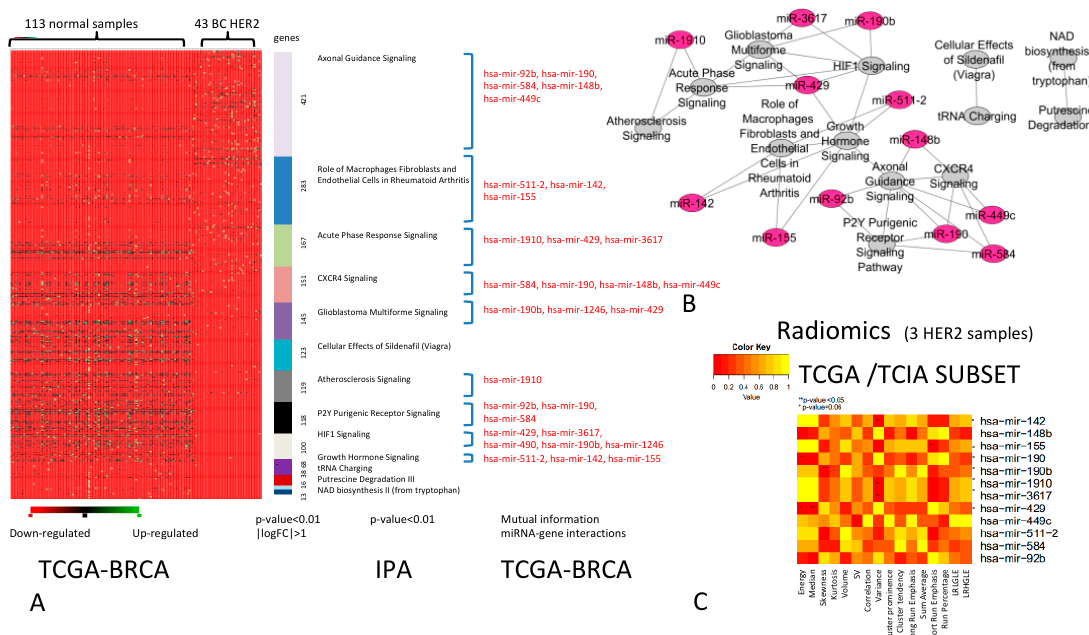
Figure 3. BC HER2+. ( A ) The pathways able to classify HER2+ BC vs. normal samples ( p -value < 0.01, |logFC| > 1). For each pathway (indicated in different colours), miRNAs (in red) able to regulate DEGs are indicated. ( B ) Relationships between pathways and miRNAs (the green nodes are the pathways and purple nodes the miRNAs). ( C ) Heatmap of the correlation between imaging features and miRNAs. The color intensity in the figure shows the corresponding p -value; yellow cells indicate greater statistical significance.